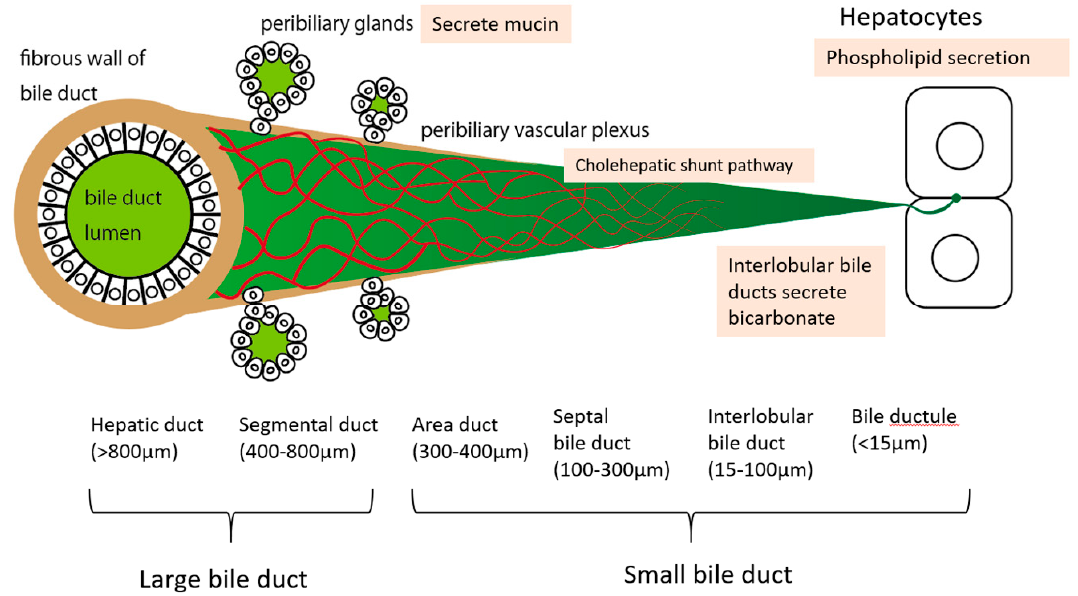
Figure 1. Image illustrates the size and characteristics of the intrahepatic bile ducts.